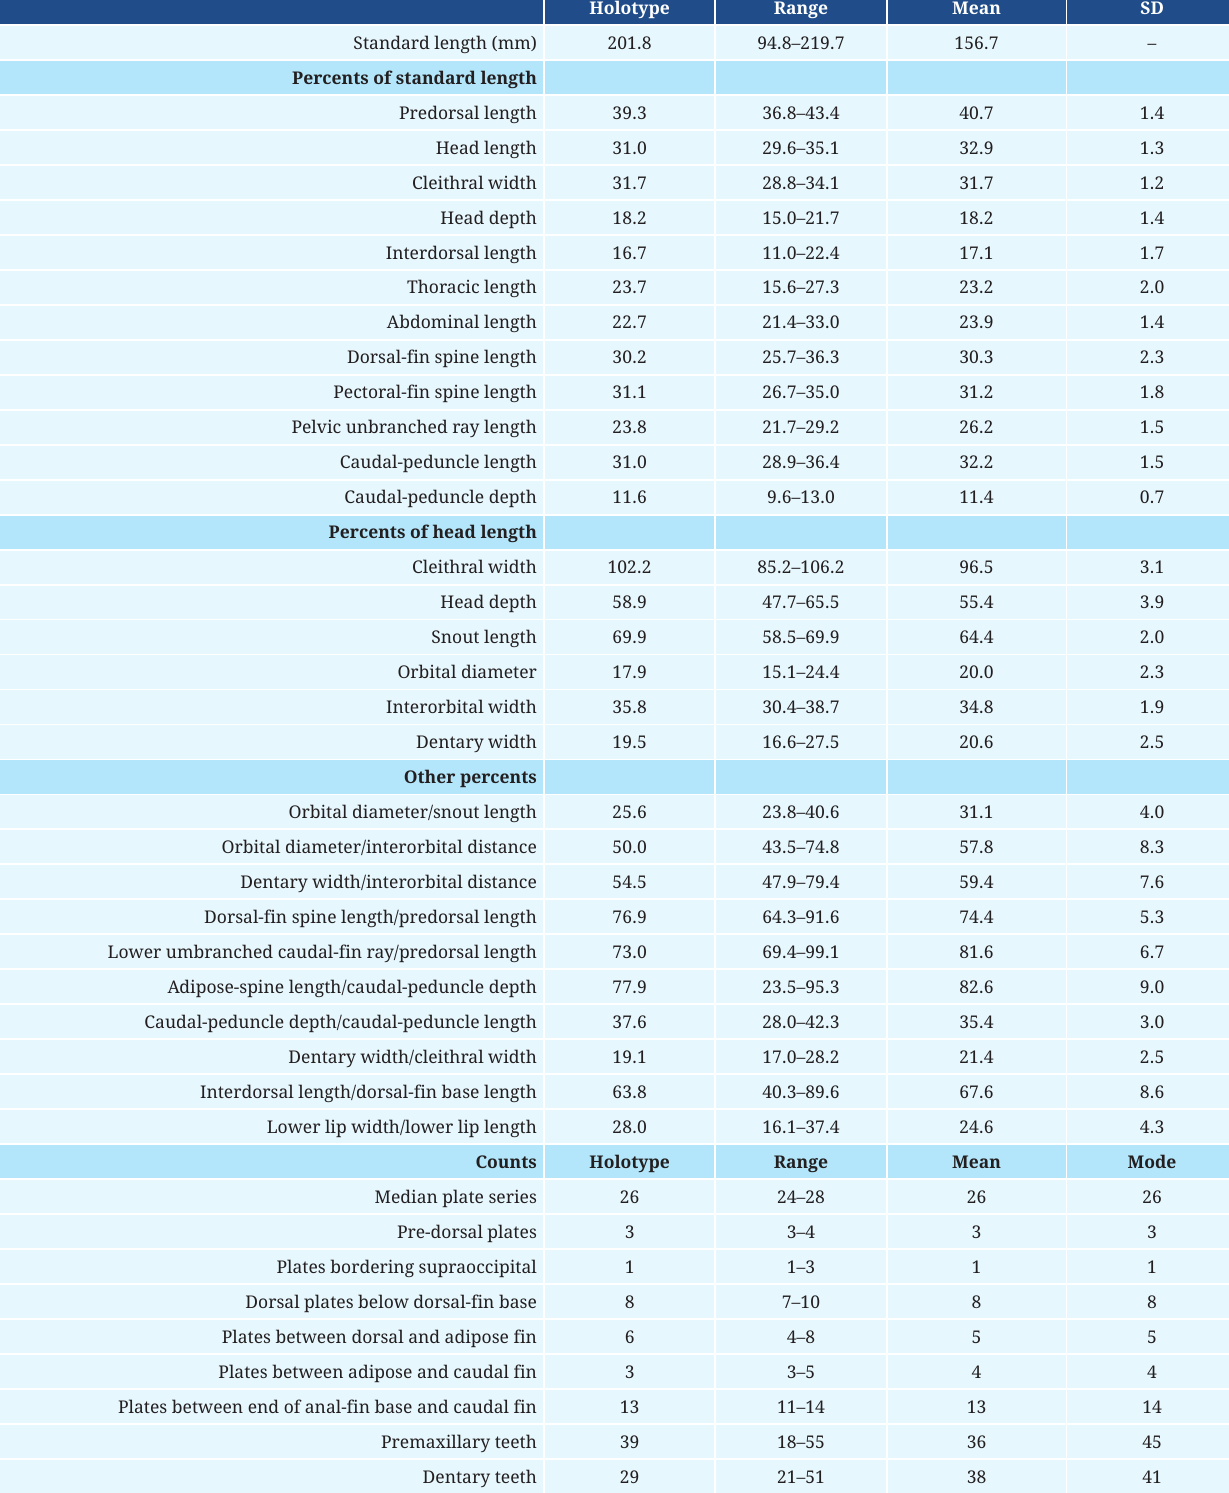
TABLE 2 | Counts and morphometric data of Hypostomus hermanni from Upper Paraná River basin. H, holotype; SD, standard deviation. Range includes the holotype and 76